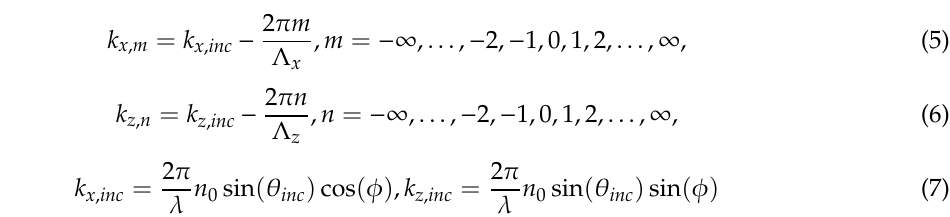
Figure 2. The dispersion relation of the dielectric multilayer for ( a ) TE and ( b ) TM polarization (the white zone denotes the stop band and the blue zone denote the non-radiative modes for the BSW and the red solid lines represents the speed of light in a vacuum, while the green point shows the working mode) when t buf = 24 μ m, t bas = 80 μ m. ( c ) n 0 versus k x when the frequency of the incident terahertz wave is 14THz, provided with the TE polarization.